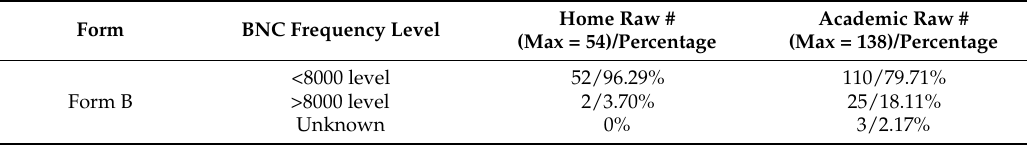
Table 2. Frequency levels within the academic and home categories on the Peabody picture vocabulary test (PPVT)-4.